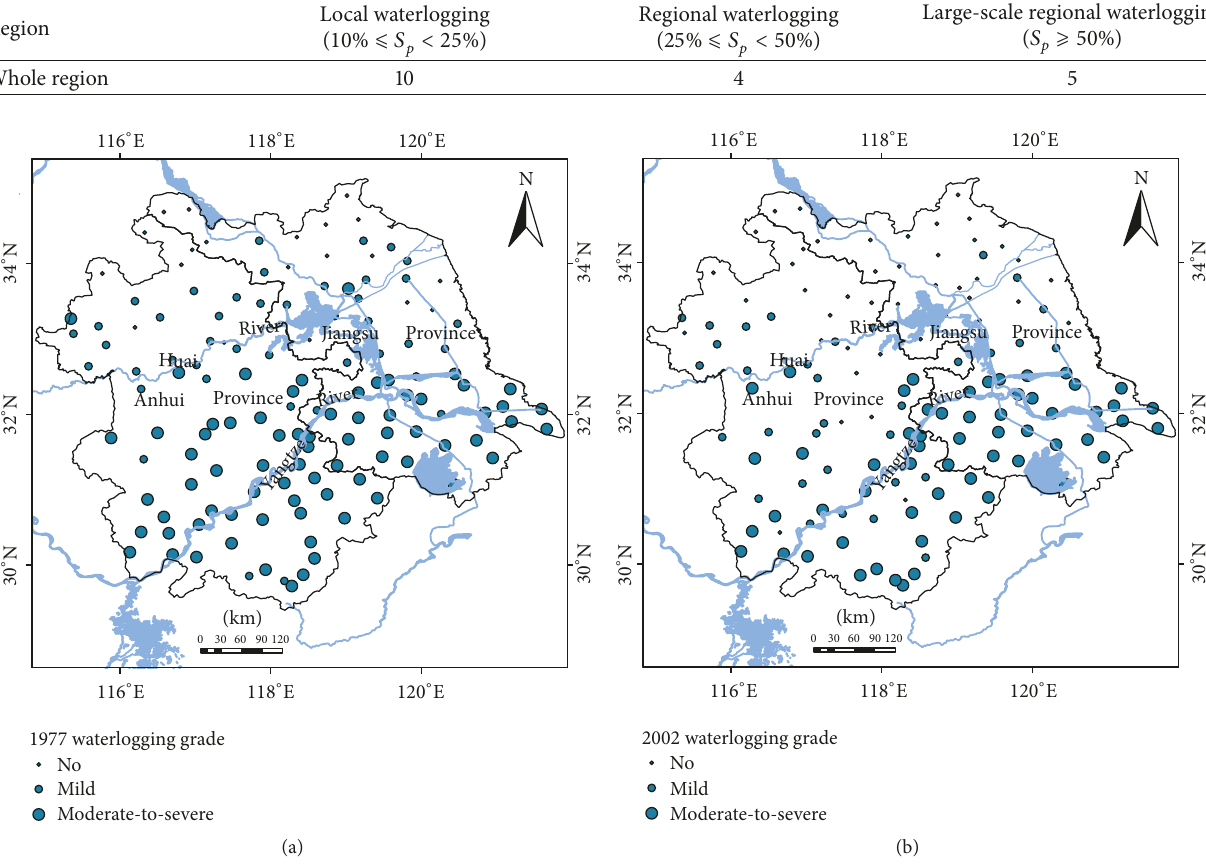
Table 4: Number of years of various waterlogging station proportions for winter wheat in the whole region from 1971 to 2010. Region